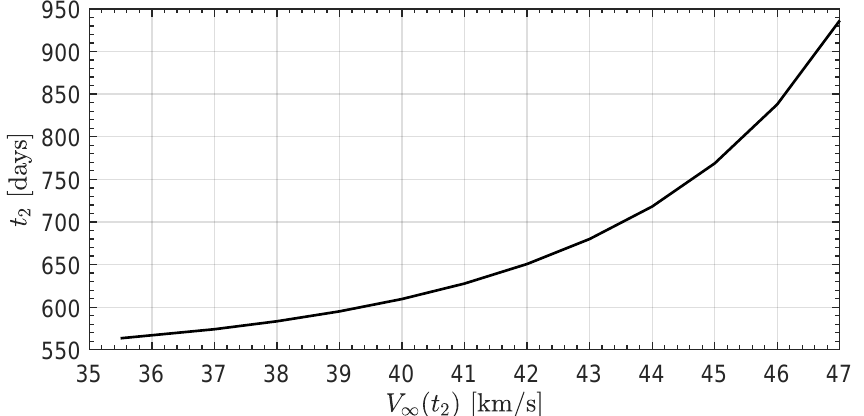
Figure 16. Flight time necessary to complete phases 1 and 2 as a function of the hyperbolic excess velocity at the end of phase 2.